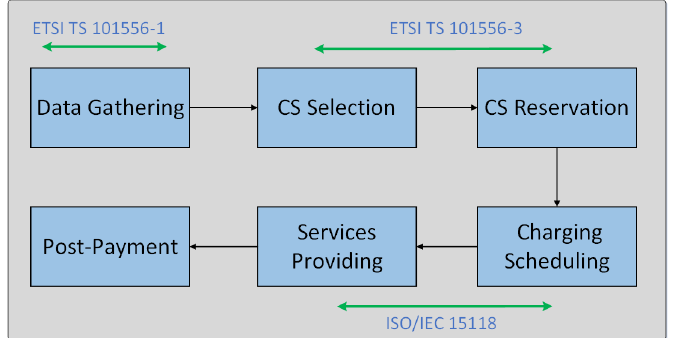
Figure 2. Transaction Cycle of Energy